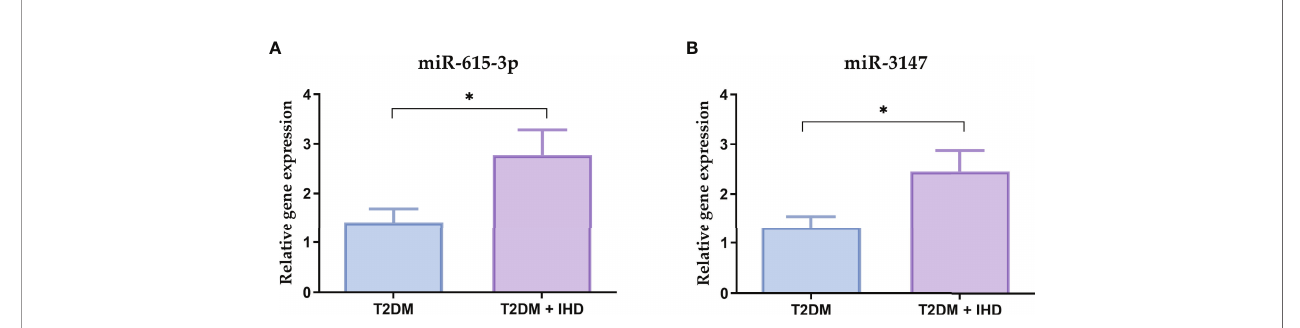
FIGURE 8 | Relative mRNA expressions of the miR-615-3p (A) and miR-3147 (B) in the serum samples in the group of 22 T2DM and 26 T2DM IHD patients. Each bar represents the mean ratio of gene expression and miR-103a-3p and miR-199b-5p ± standard error of the mean. Signi fi cance: U Mann-Whitney test; *p < 0.05 in comparison